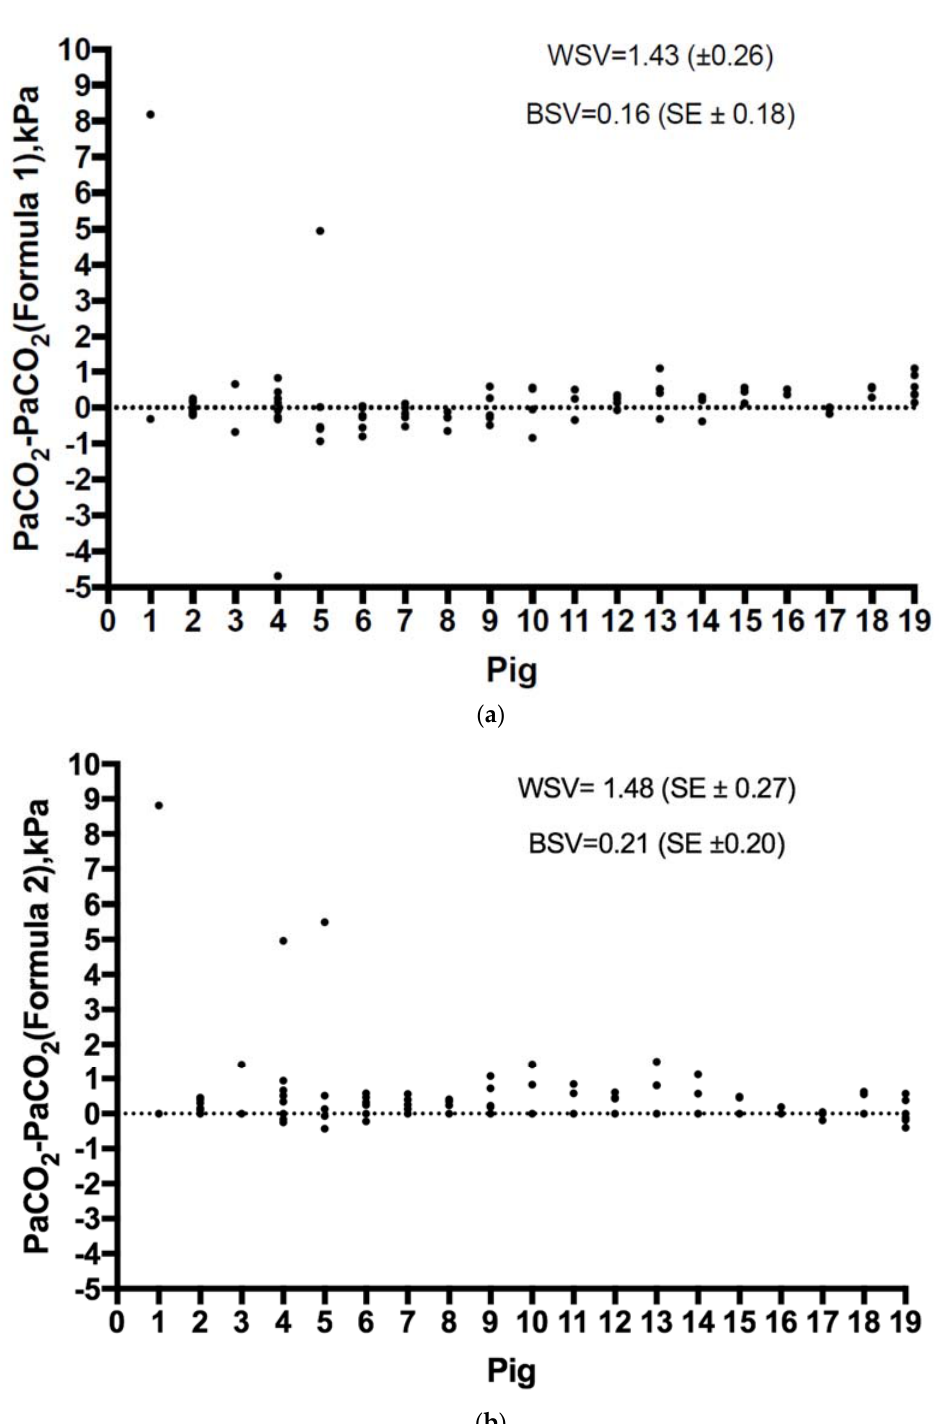
Figure 3. ( a ) The difference between PaCO 2 (Formula 1) and measured PaCO 2 for each animal. ( b ) The difference between PaCO 2 (Formula 2) and measured PaCO 2 for each animal . WSV, within-subject variance; BSV, between-subject variance.